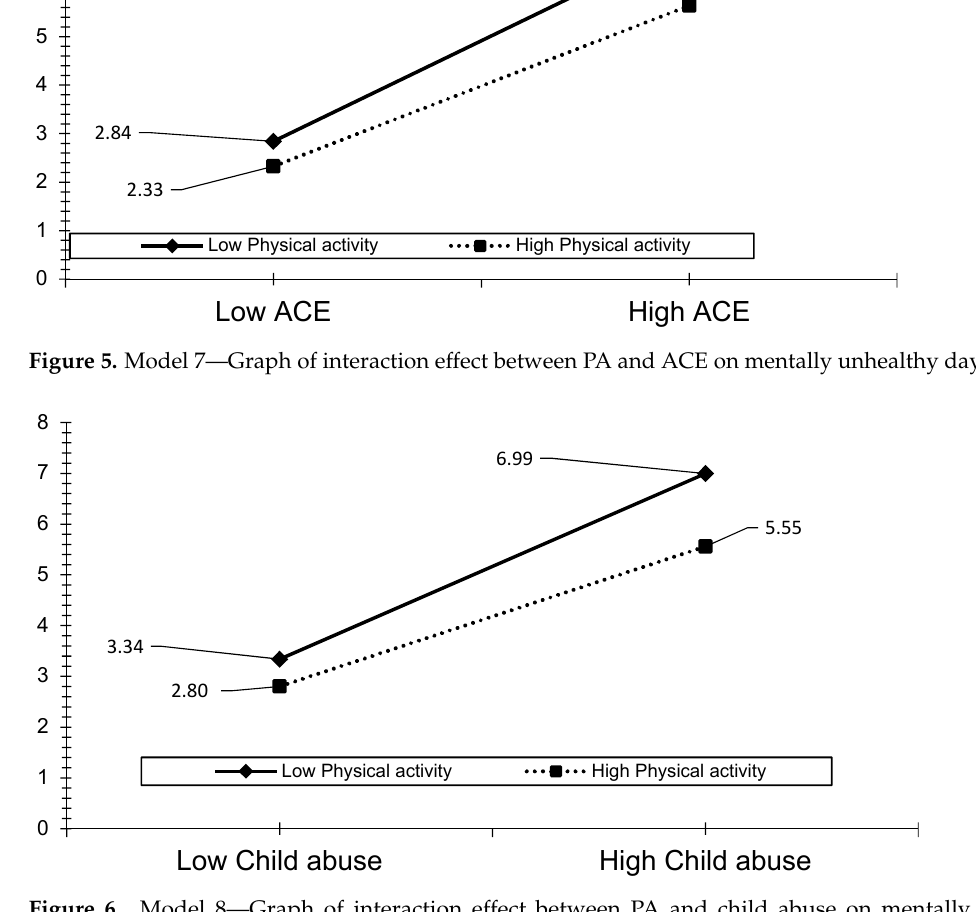
Figure 6. Model 8—Graph of interaction effect between PA and child abuse on mentally unhealthy days.